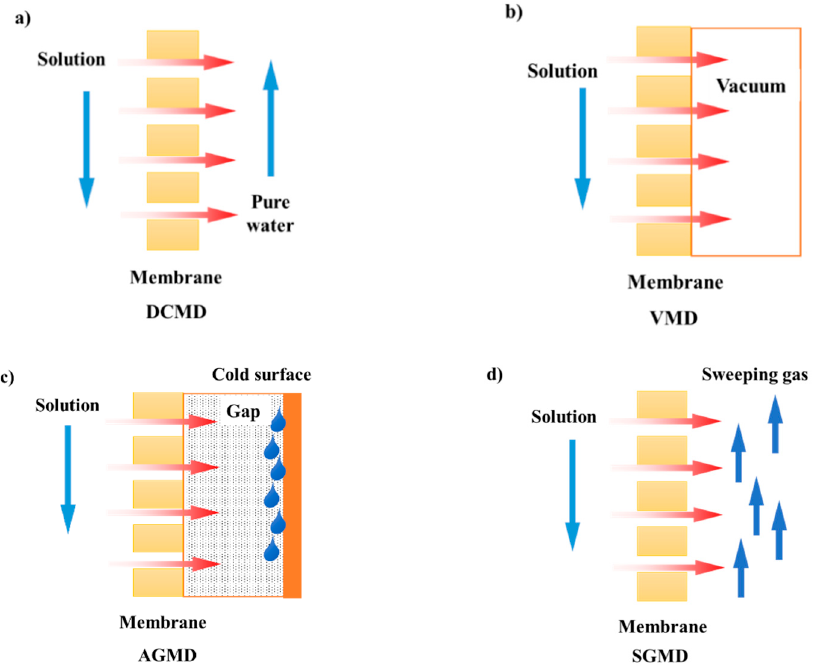
Figure 7. Main configurations of MD process: ( a ) direct contact membrane distillation (DCMD); ( b ) vacuum membrane distillation (VMD); ( c ) air gap membrane distillation (AGMD); ( d ) sweep gas membrane distillation (SGMD).